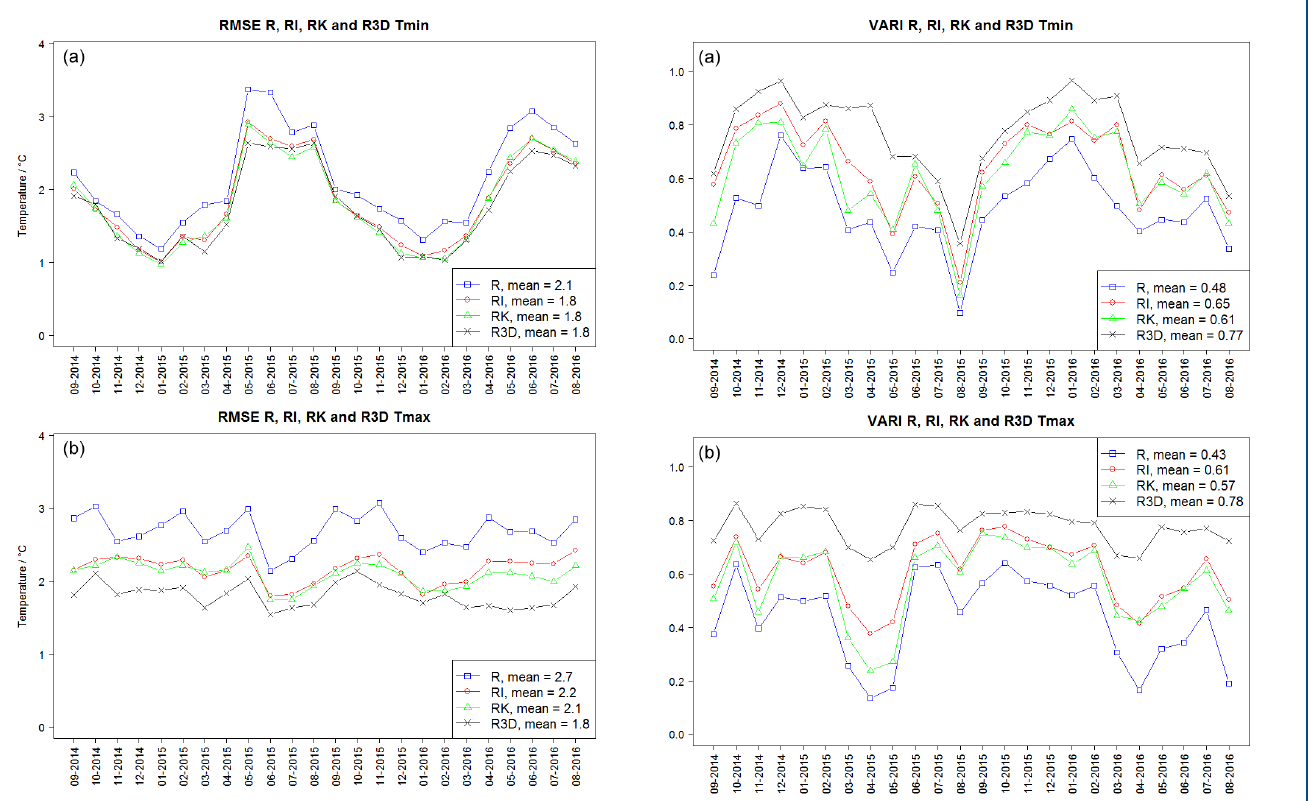
Figure 3. Results of the VARI calculation for all interpolation models, where R = Regression, RI = Regression + two dimensional IDW, RK = Regression + Kriging, R3D = Regression + three di- mensional IDW, for minimum temperature (a) and maximum tem- perature (b)